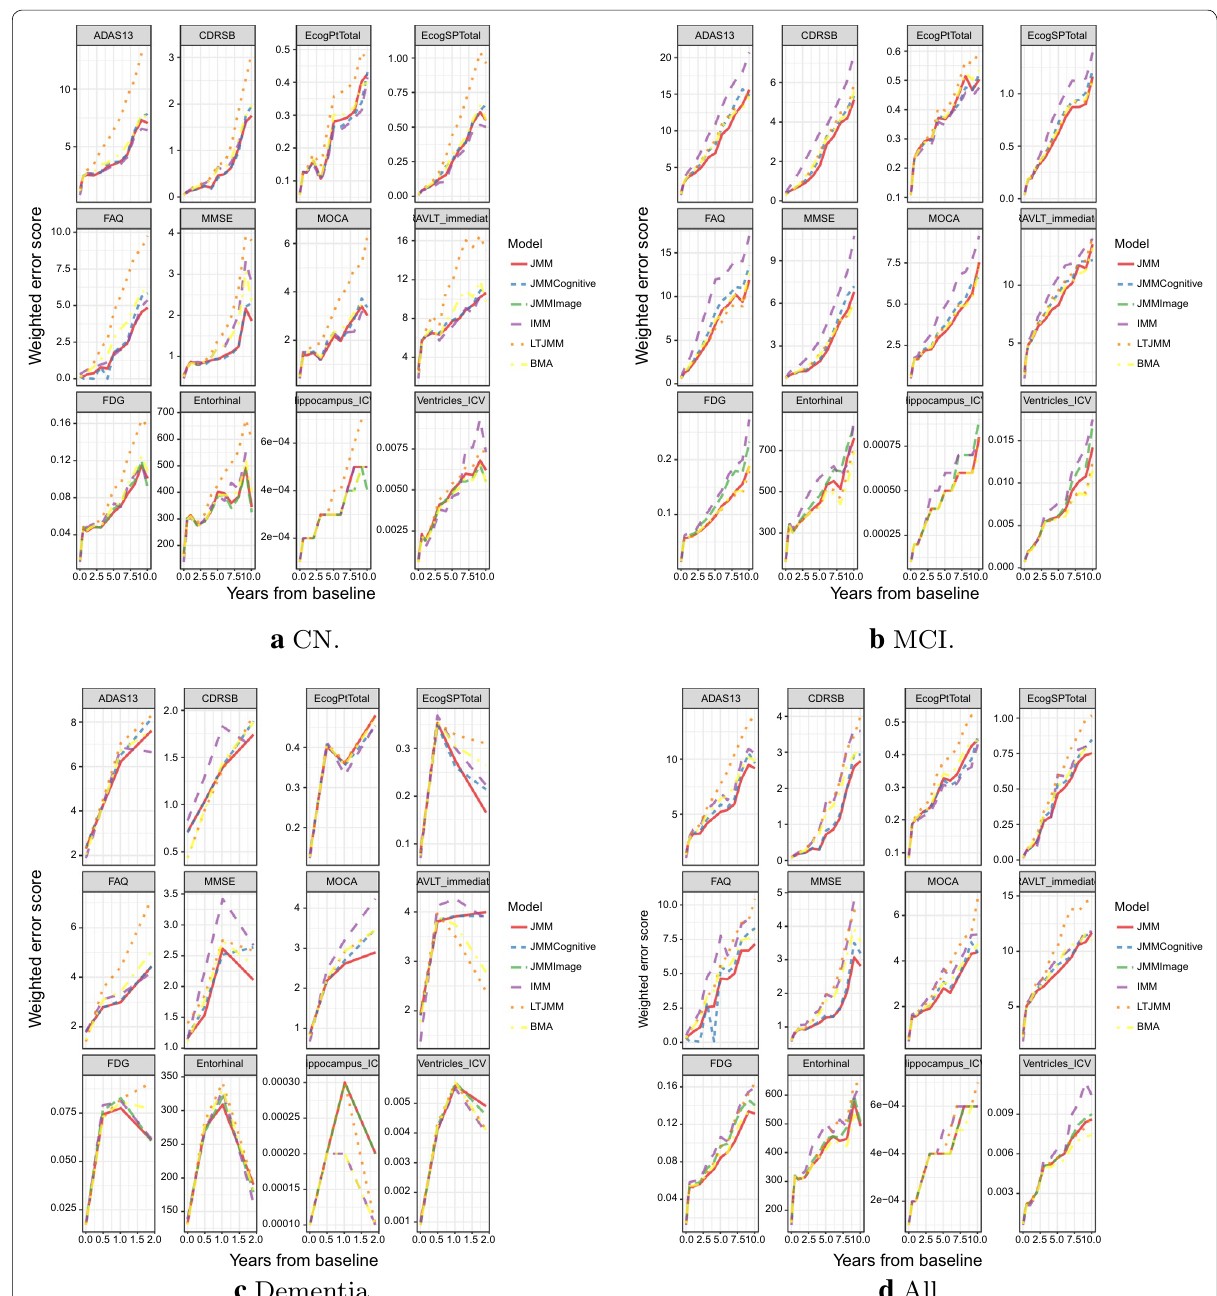
Fig. 4 Validation set weighted error scores over time for each model by diagnosis. CN Control, MCI mild cognitive impairment, IMM independent mixed-effects model, JMM joint mixed-effects model, LTJMM latent-time joint mixed-effects model, BMA Bayesian model averaging, JMMCognitive JMM fitted to cognitive and function outcomes only, JMMImage JMM fitted to imaging markers